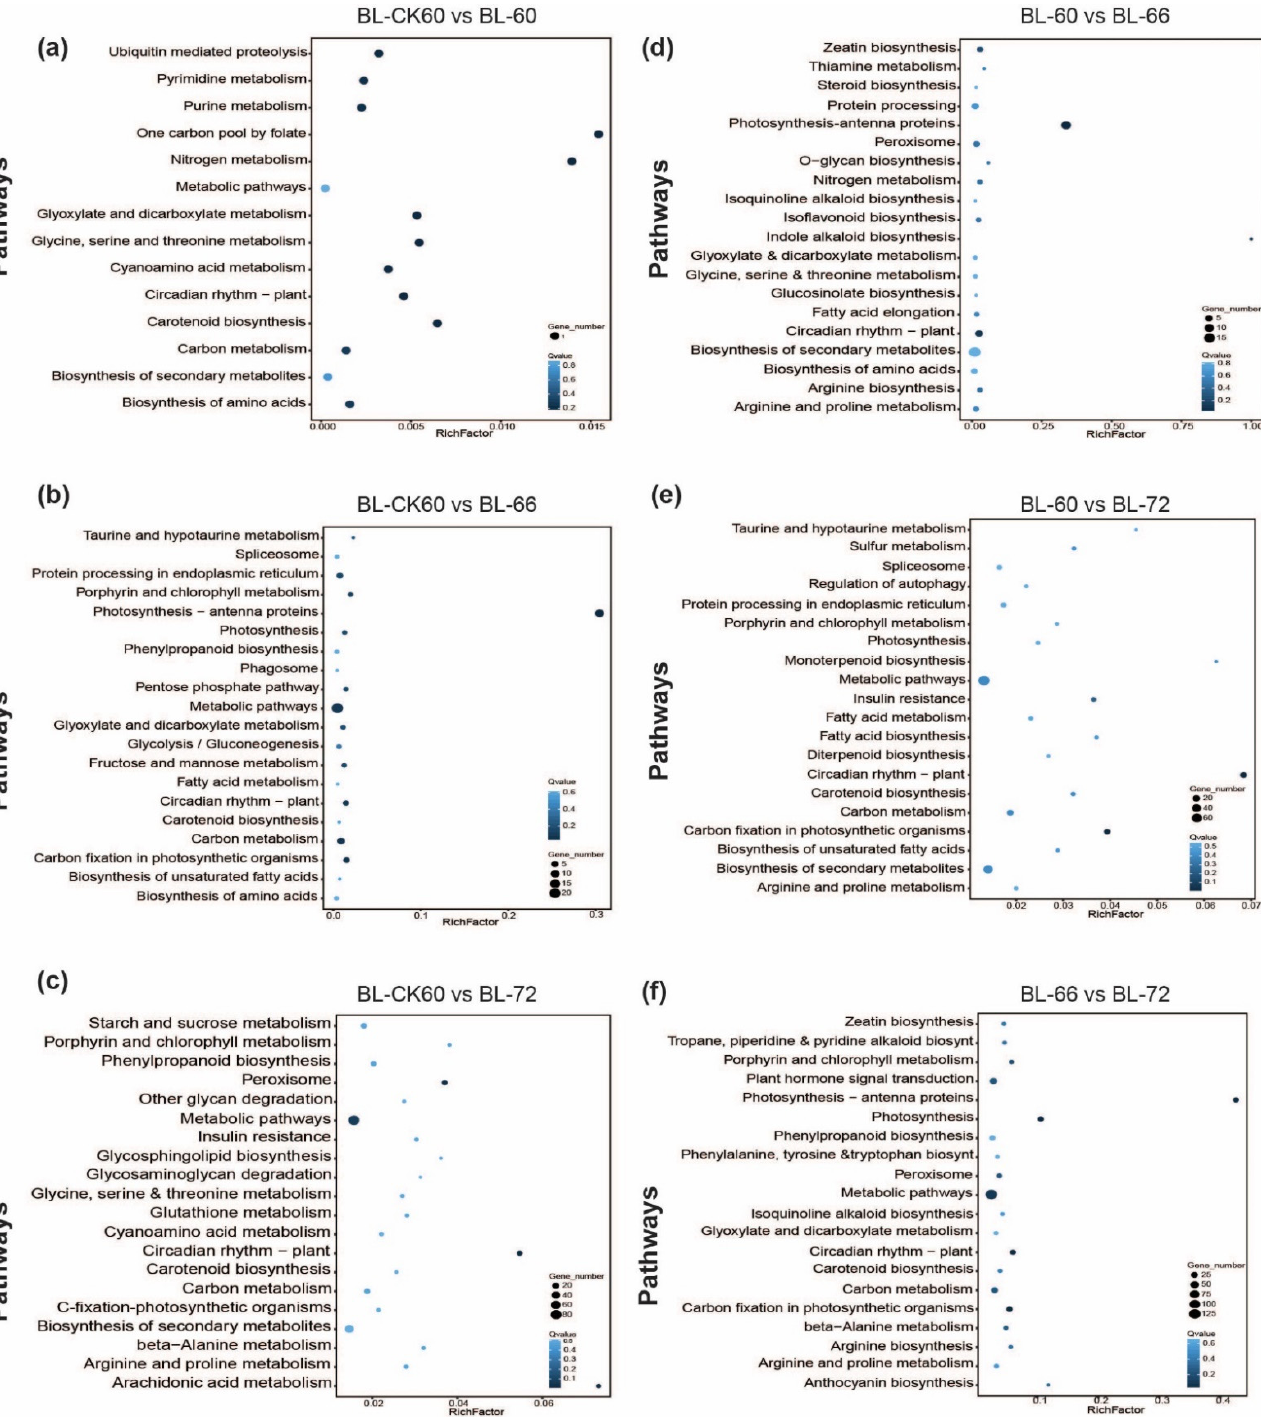
Figure 4. KEGG pathway classification of DEGs between control and treatment and among treatments at three tested time points (60 h, 66 h, and 72 h); ( a–c ) KEGG pathway classification of DEGs between control and treatment at tested time points (60 h, 66 h, 72 h); ( d–f ) KEGG pathway classification of DEGs among treatment comparisons at tested time points (60 h, 66 h, 72 h).